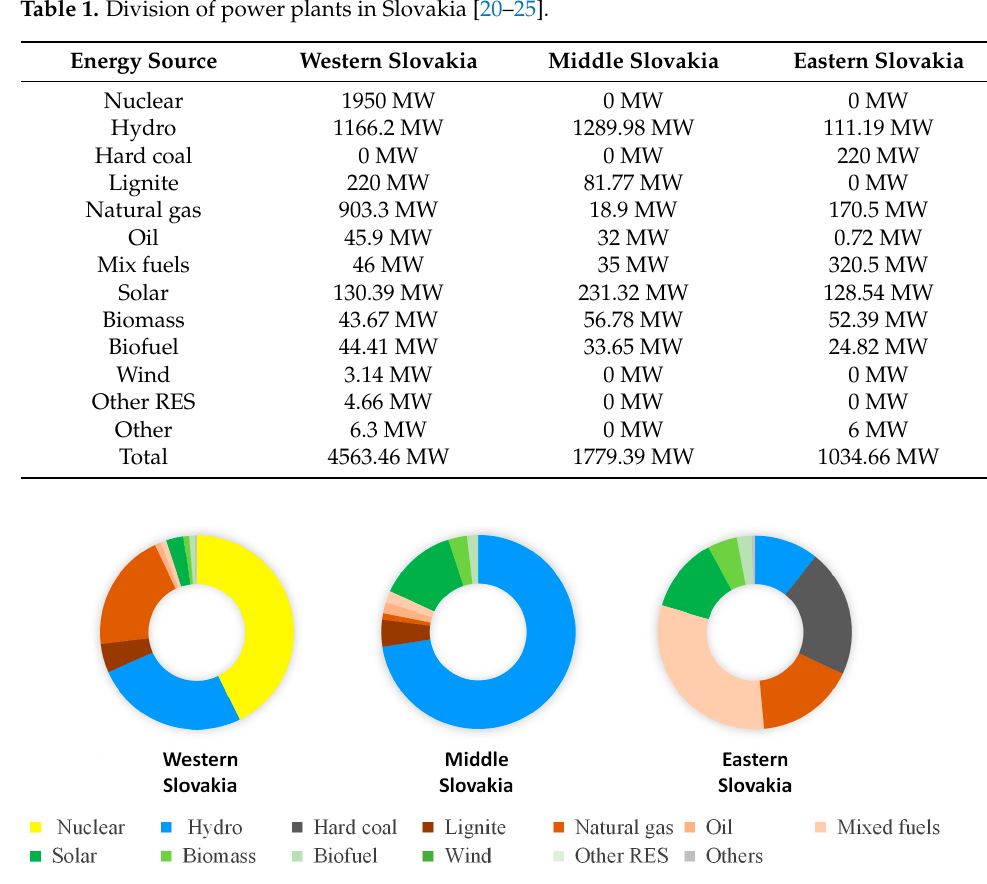
Figure 5. Division of power plans in Slovakia [20–25]. Table 1. Division of power plants in Slovakia [20–25].